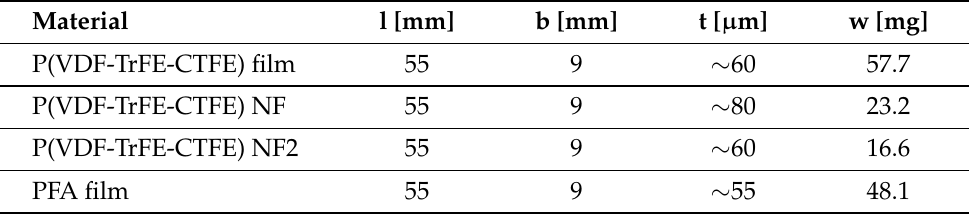
Table 1. Dimensions (Length l, Breadth b, Thickness t, Weight) of the specimens of P(VDF-TrFE-CTFE)